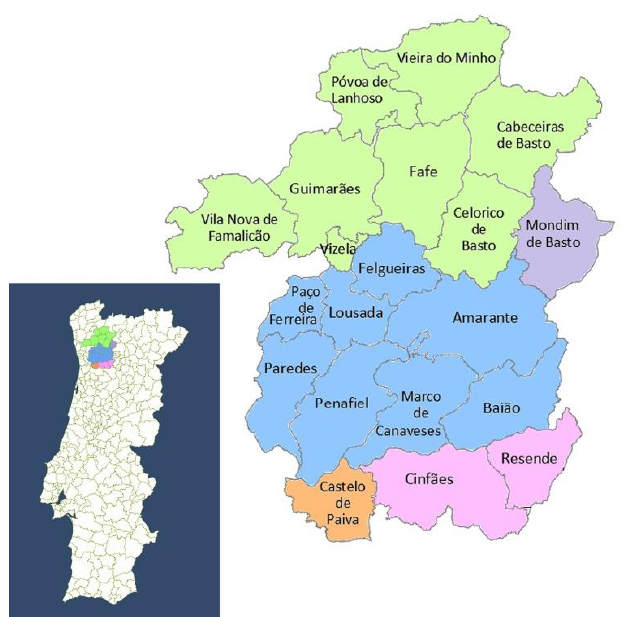
Figure 3. The 20 municipalities in Northern Portugal under study.